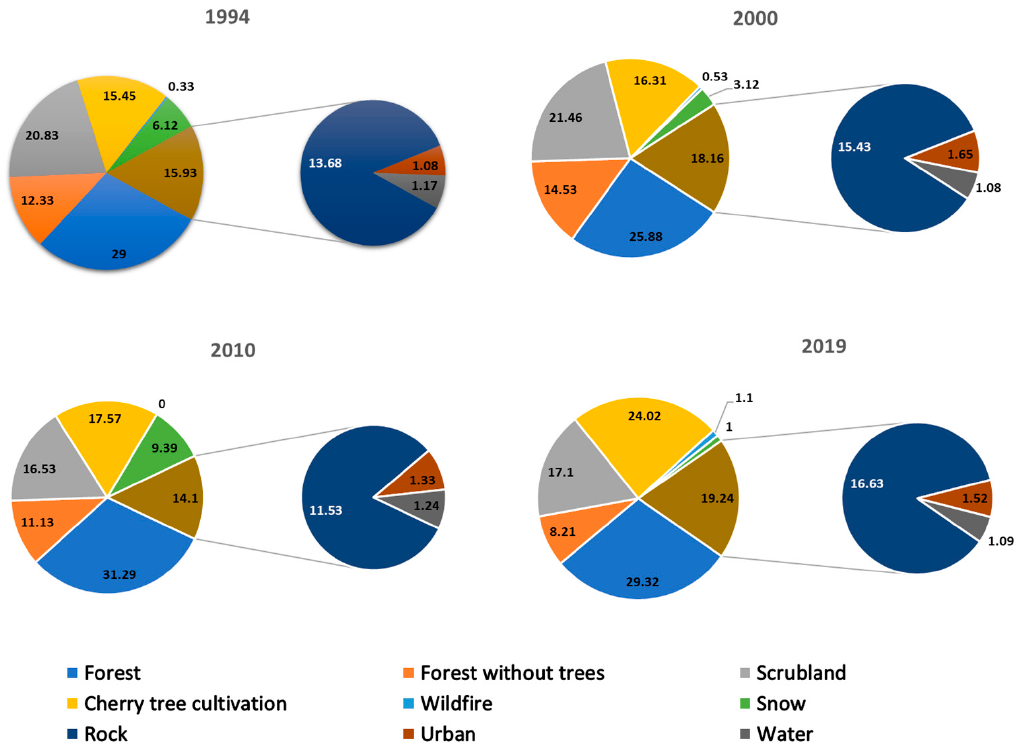
Figure 4. Evolution of land use in the last 4 decades in the Jerte Valley.